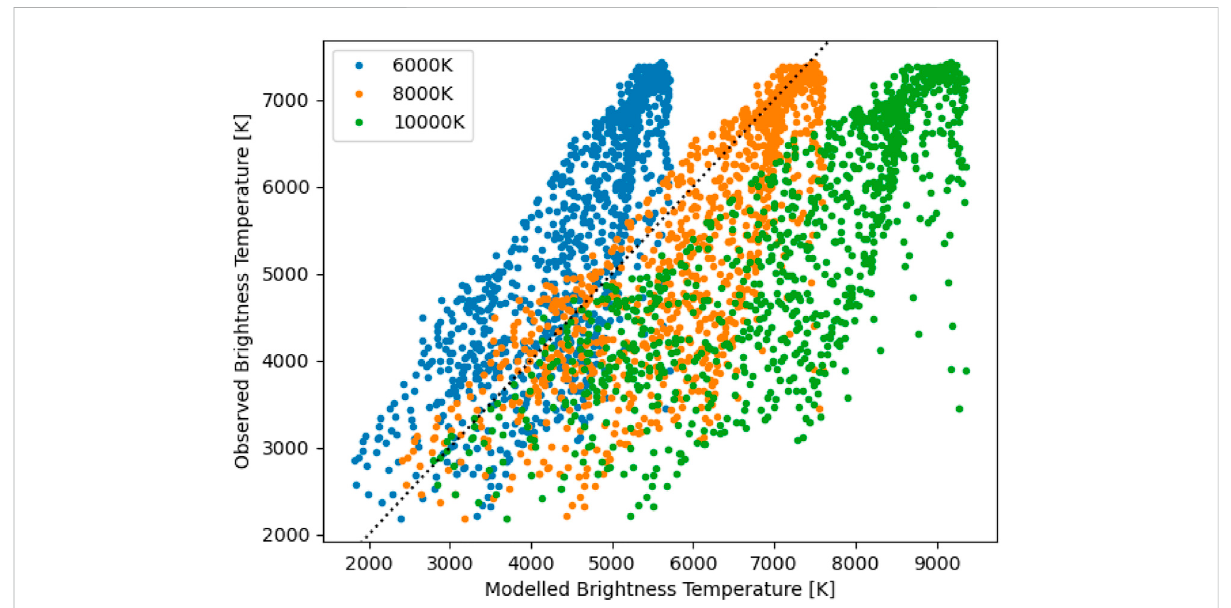
FIGURE 8 Relationship between observed brightness temperature from ALMA and that modelled using the H α MSDP data. The modelled brightness temperatures are estimated at 6000, 8000, and 10000 K. The dotted line shows when the observed and estimated brightness temperatures are equal. Reproduced from Labrosse et al. (2022).